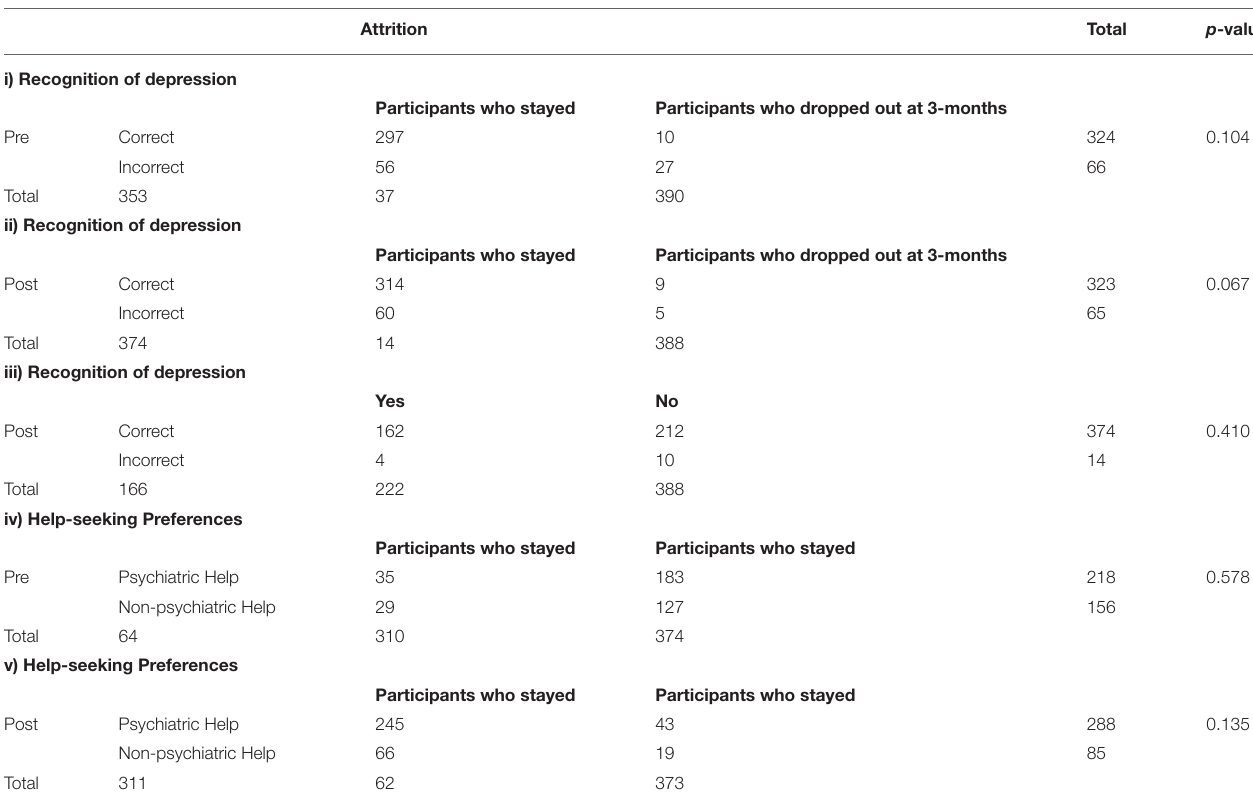
TABLE 6 | Post-hoc sensitivity analyses of: (i) recognition of depression between participants who dropped out and those who didn’t at pre-intervention (ii) recognition of depression between participants who dropped out and those who didn’t at post-intervention (iii) recognition of depression between participants with close friend/family with MI and those without at post-intervention (iv) help-seeking preferences between participants between participants who dropped out and those who didn’t at pre-intervention (v) help-seeking preferences between participants between participants who dropped out and those who didn’t at post-intervention. Attrition Total p -value i) Recognition of